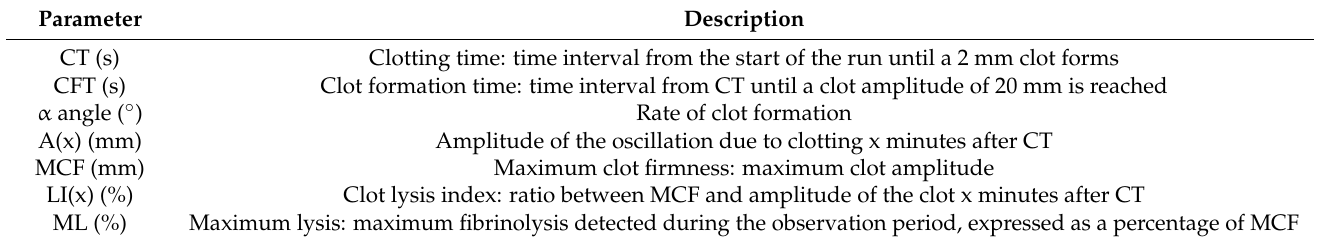
Table A2. ROTEM®parameters.